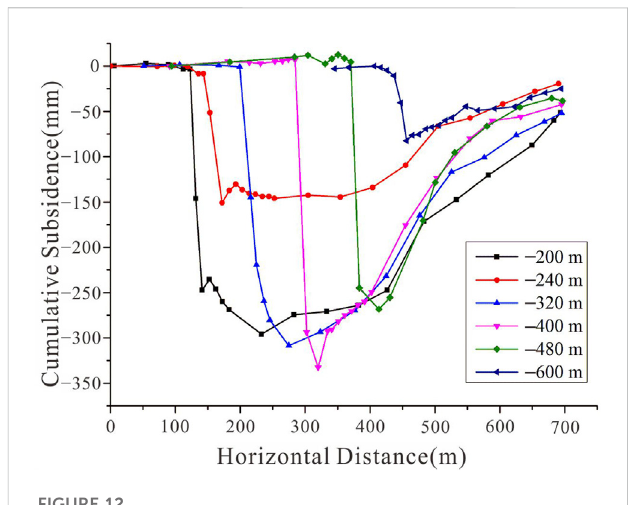
FIGURE 12 Cumulative subsidence of various sublevels of the No. 55 prospecting pro fi